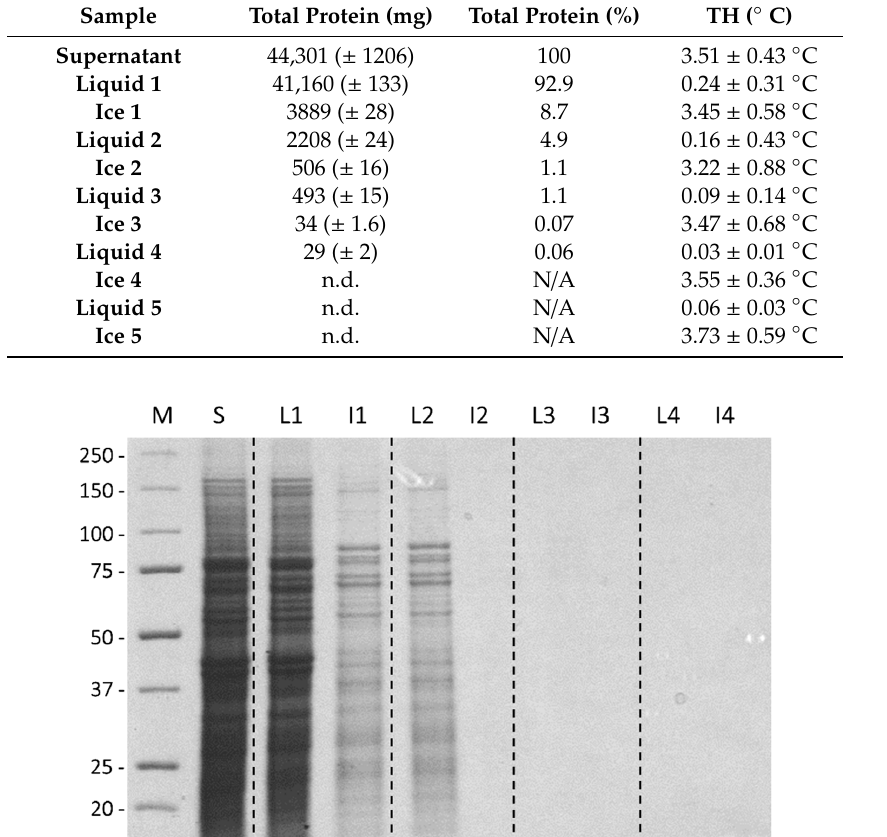
Figure 3. Coomassie blue-stained SDS-PAGE analysis of serial ice-affinity purifications. Lanes were loaded with liquid (L) and ice (I) fractions on an equal volume basis (lanes 3–10) relative to the starting material (S) (lane 2). Samples represented in each lane are as follows: protein markers in kDa (M),